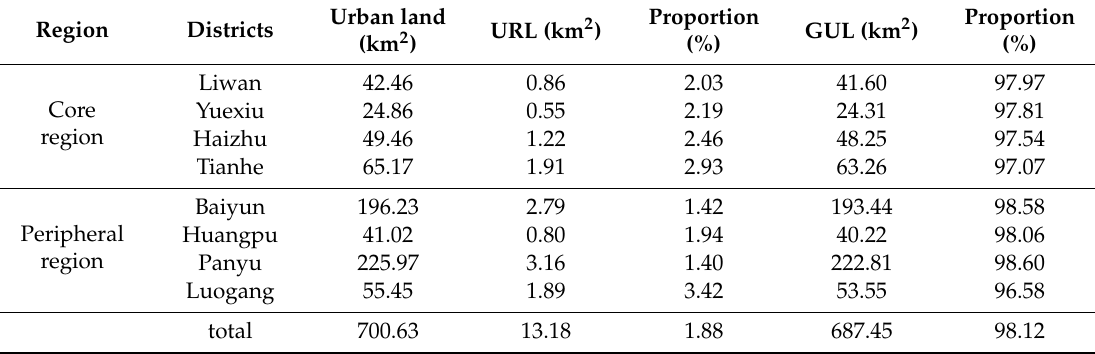
Table 2. Spatial distribution of urban renewal land (URL) and general urban land (GUL) in di ff erent districts from